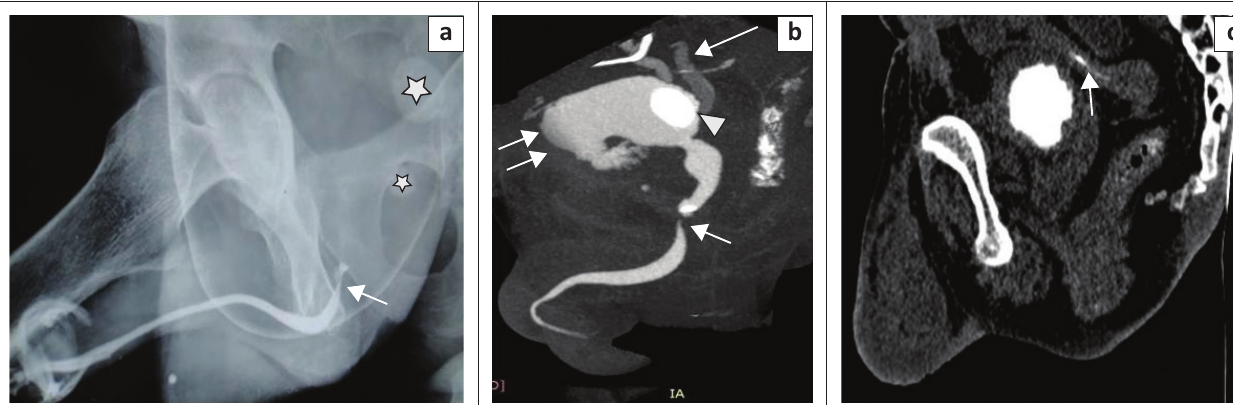
FIG URE 11: (a) Retrograde urethrography (RGU) image showing a normal anterior urethra with tapering at the bulbomembranous junction (arrow) and no distal passage of contrast into the posterior urethra. Micturating cystourethrography could not be performed because of unsuccessful catheterisation. A confident diagnosis of a stricture could not be made. Two calculi (asterisks) were noted, but exact localisation was difficult on RGU. (b) Sagittal maximum intensity projection image (multidetector computed tomographic urethrography [MDCTU]) demonstrates the membranous urethral stricture, posterior urethral calculus (short arrow), vesical calculus (arrowhead), irregular shaped bladder with contrast leakage into the perivesical tissues (double arrows) and bilateral vesico-ureteric reflux (VUR) (long arrow). (c) Sagittal multiplanar reformatting image (MDCTU) of the same patient showing part of the rectum in close proximity to the dome of the bladder, with loss of intervening fat planes and contrast noted inside the rectum (arrow), suggestive of rectovesical